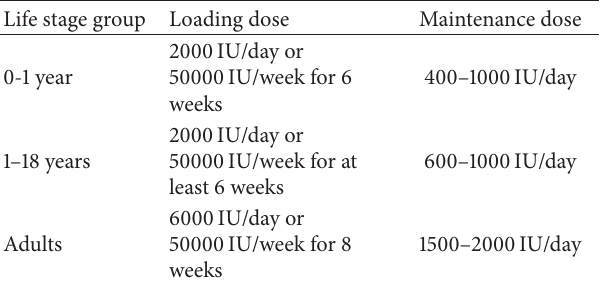
Table 2: Vitamin D (vitamin D 2 and vitamin D 3 ) treatment for vitamin D deficiency as recommended by the Endocrine Society for the treatment of vitamin D